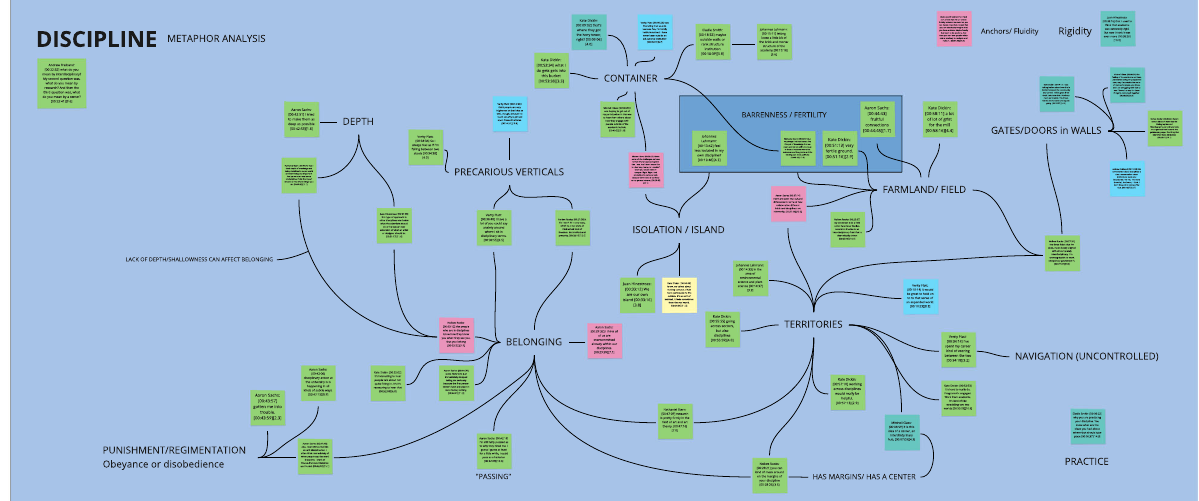
Fig. 4 Metaphor analysis of how ‘ disciplines ’ were perceived which allows identi fi cation of ’ undisciplining ’ . Quotes were extracted from the transcripts of the charrette and scanned for metaphors used (shown in Fig. 3), which were highlighted, organized, and analyzed through a manual qualitative study (charrette methodology described in Fig. 2; colors correspond to sessions shown in Fig. 3: introduction green, ‘ WHO ’ yellow, ‘ HOW ’ magenta, ‘ WHEN ’ blue, ‘ WHERE ’ olive).